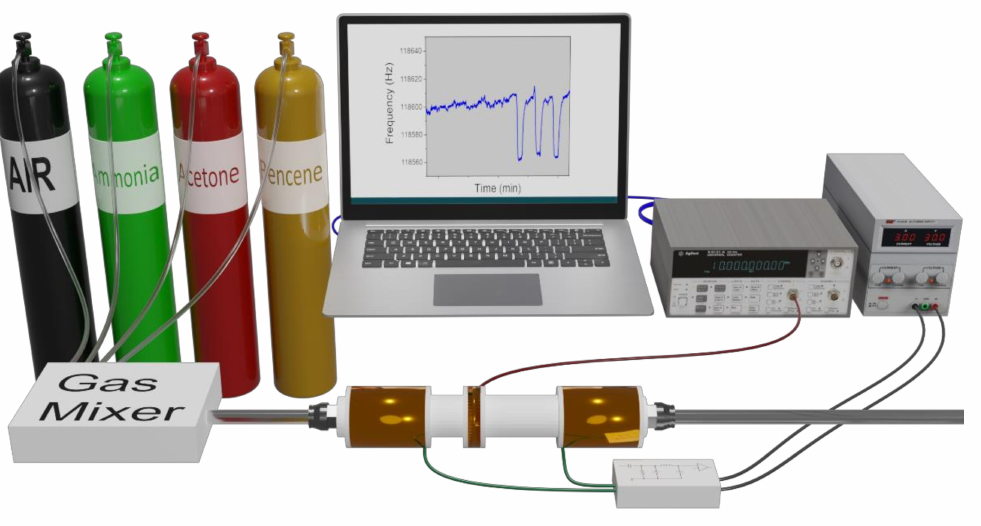
Figure 3. Experimental setup for the real-time monitoring of the magnetoelastic resonance-based gas